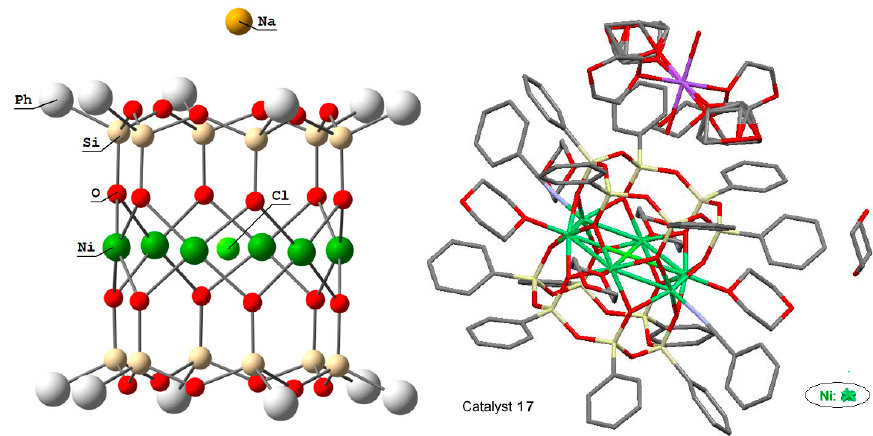
Figure 12. Molecular structure of compound (PhSiO 1.5 ) 12 (NiO) 6 (NaCl), 17 . Adapted from Ref. [228].